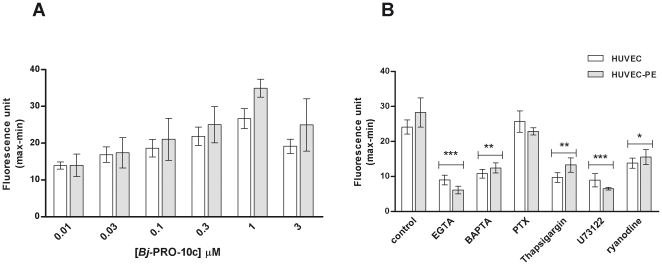
Characterization of Bj-PRO-10c-induced [Ca2+]i elevations in endothelial cells.
A. Changes of maximal peak heights of [Ca2+]i responses induced by increasing concentrations of Bj-PRO-10c (0.01–3 µM) were measured in HUVEC and HUVEC-PE by microfluorimetry. B. Evaluation of Bj-PRO-10c-induced [Ca2+]i transients in HUVEC and HUVEC-PE in the presence of chelating agents and specific inhibitors of Ca2+ signaling. Cells were pre-incubated for 5 or 30 min with 10 mM EGTA or 10 µM BAPTA (extracellular and intracellular Ca2+ chelators), respectively. Cells also were pre-treated for 18 h with 100 ng/ml pertussis toxin (PTX) for inhibition of Gi/o-protein mediated receptor responses and for 30 min with U73122, a PLC-γ inhibitor. Calcium release from intracellular stores was inhibited by a 30 min pre-incubation of cells with 200 ng/ml thapsigargin. The participation of ryanodine-sensitive calcium stores was studied following 30 min pretreatment of cells with 50 µM ryanodine. * P<0.05, ** P<0.01 and *** P<0.001 compared to Bj-PRO-10c control data obtained in the absence of pre-treatment. The shown data are mean values ± S.E. of five independent experiments.